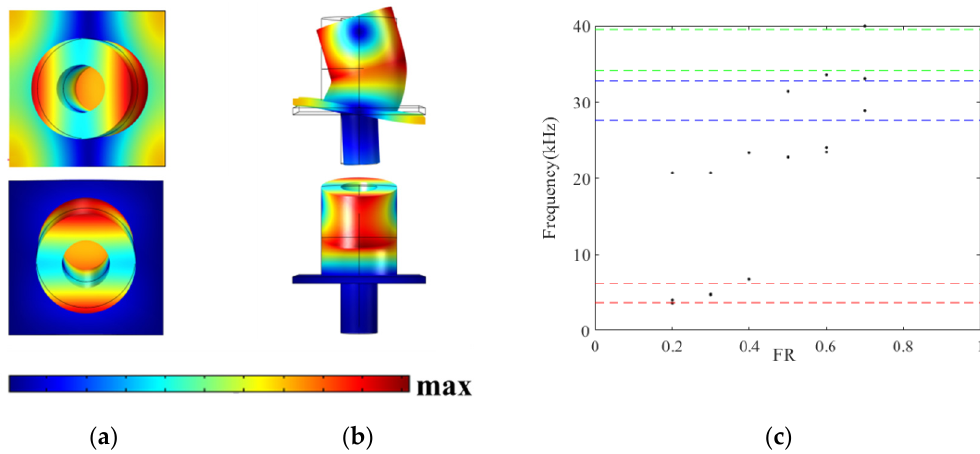
Figure 4. Displacement field distribution and dispersion branch with different FR . ( a ) The top view of the displacement field; ( b ) the main view of the displacement field; ( c ) The graph of the new dispersion branch X point with the different FR . The three-color dotted line represents the band gap width when the FR = 100%.